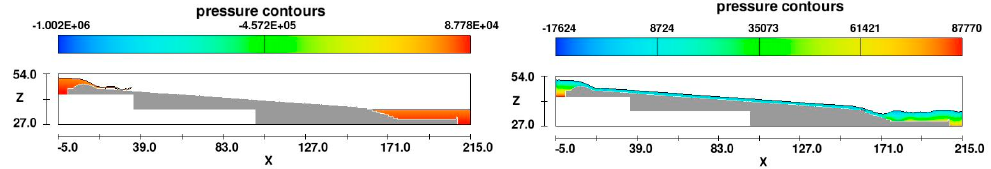
Figure 9. Results obtained with and without the air entraiment model when the input water level is Z up = 52 m.